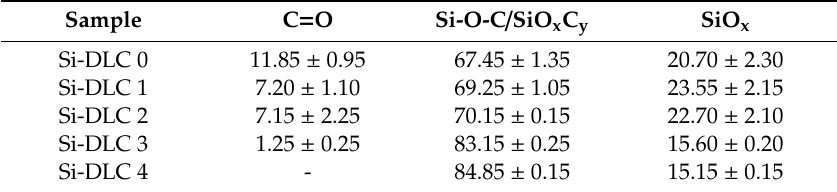
Figure 4. The sp 2 / sp 3 bonding ratio of the deposited DLC and Si-DLC coatings. Decomposition of the O 1s band, presented in Table 3, confirmed the oxycarbide bonds relative content depended on the magnetron sputtering power and the Si content in the structure of the Si-DLC films. Table 3. Decomposition of the O 1s peak for the obtained Si-DLC coatings.